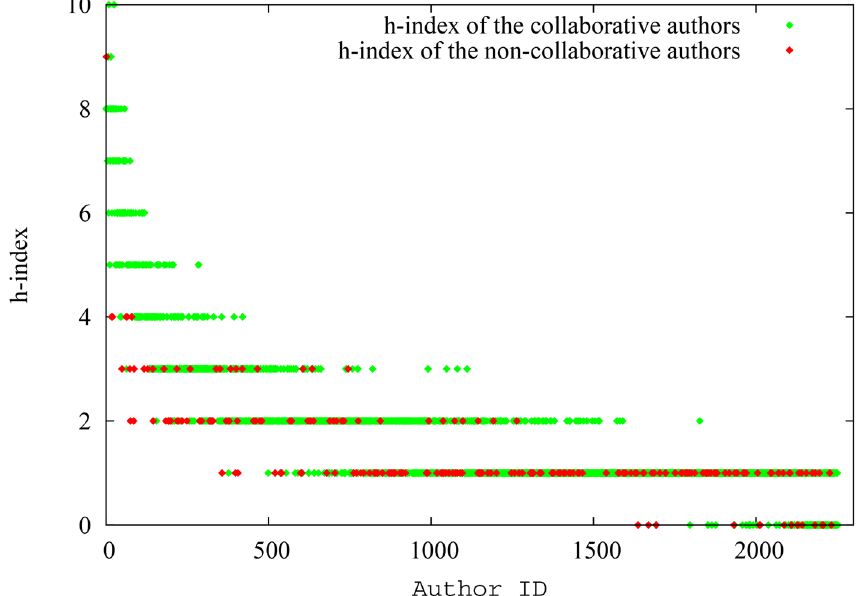
Fig 7. The spread of h-index for collaborative and non-collaborative authors (as absolute values) in scenario 2. For authors of a similar level of seniority (as indicated by their IDs), the ‘ collaborative ’ authors have a clear advantage.